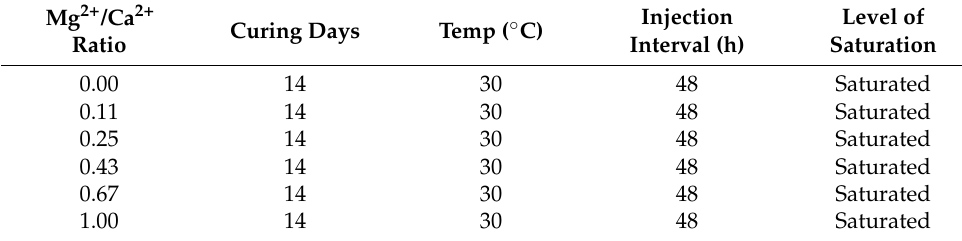
Table 3. Testing conditions for sand